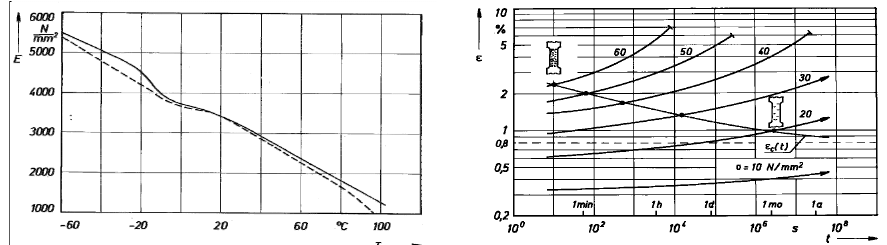
Figure 2a: Temperature dependency of modulus of elasticity and creep strength curve, b: deterioration curve of PMMA (Evonik Röhm